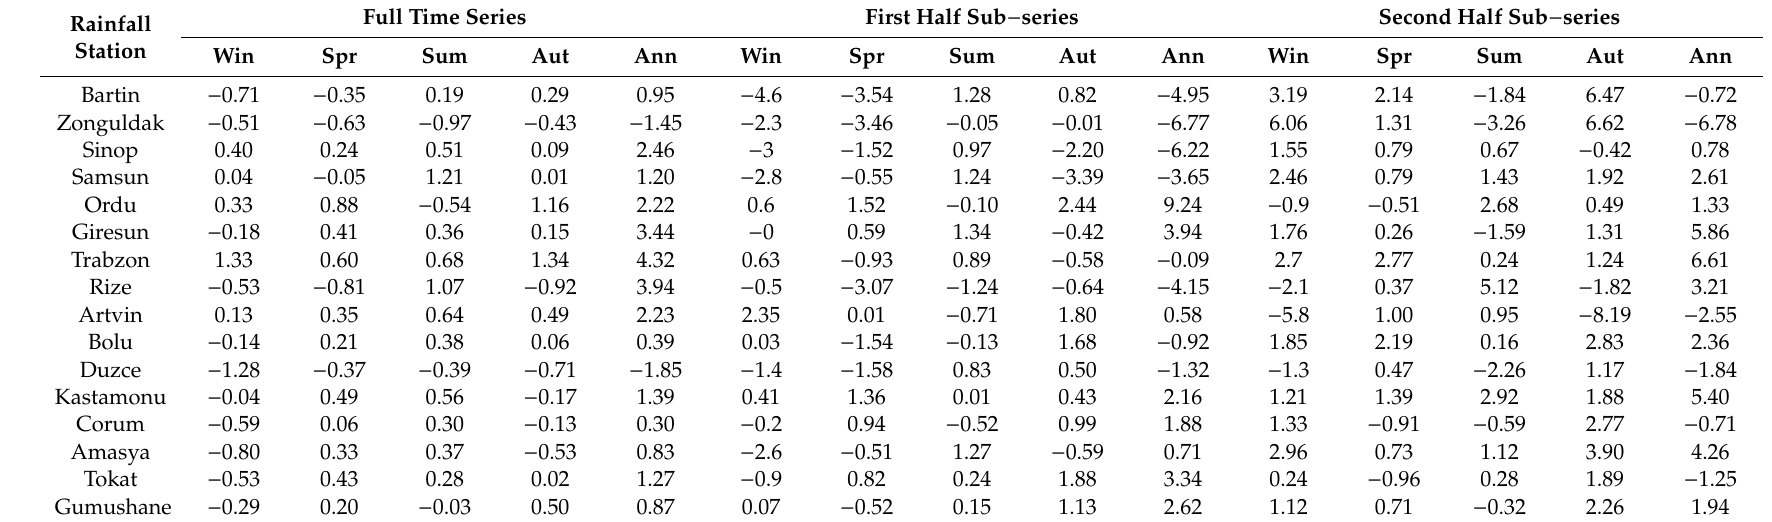
Table 3. The magnitude (mm / year) of the linear trends in annual